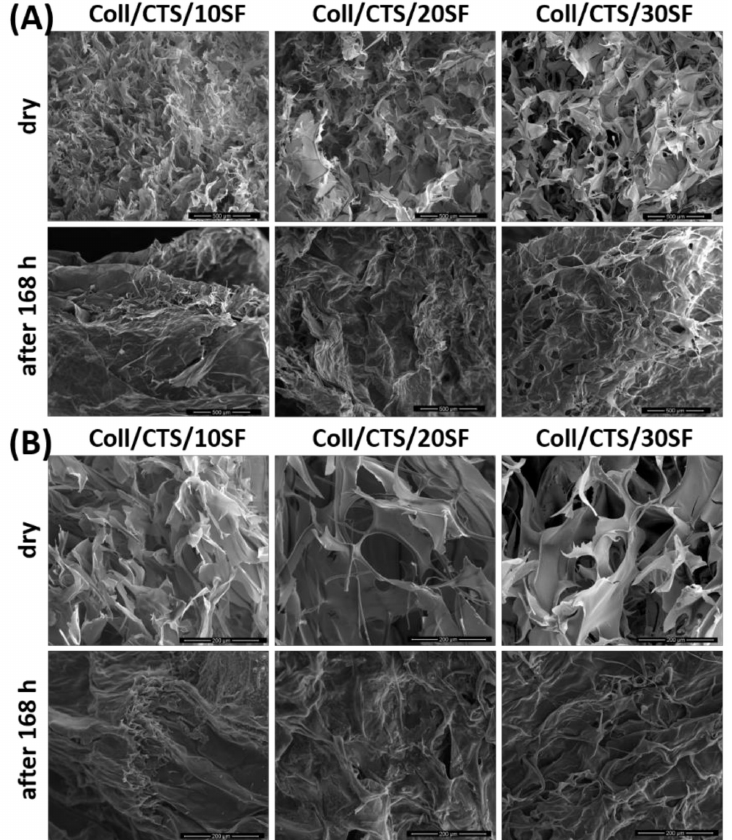
Figure 8. SEM images of Coll/CTS mixtures with 10, 20 and 30% of SF, cross-linked by EDC/NHS, for dry scaffolds and scaffolds after 168 h of immersion in PBS: ( A ) magnification 500 × ; ( B ) magnifi- cation 150 ×